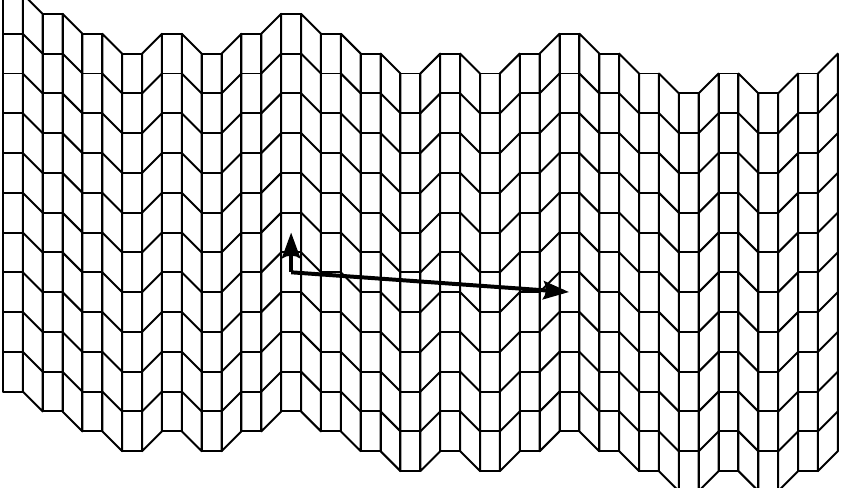
Fig. 66: A crystallographic tiling where layers repeat according to the periodic sequence . . . 0001011 . . . . Its symmetry group contains translations only. The arrows in the image indicate two translation that generate the entire symmetry